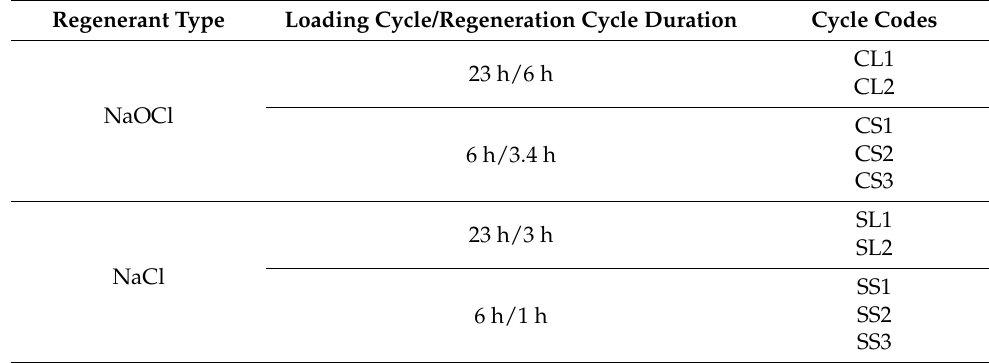
Table 1. Operating cycles characteristics and